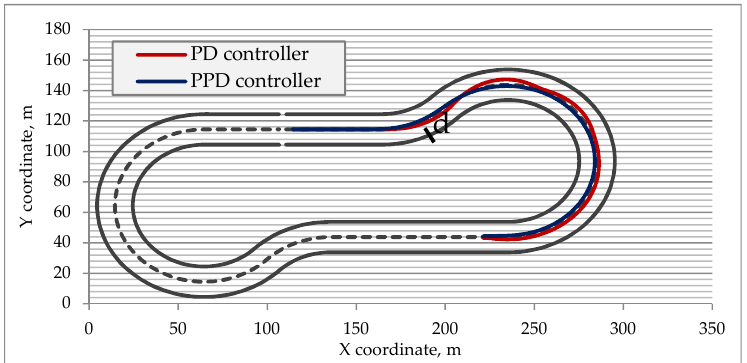
Figure 12. Distance between the car and obstacle (road turn) that caused the turn friction coefficient µ = 0.3 with target speed equal to 0.95 V . Table 7. Distance to the obstacle for each parameter combination, meter. CR